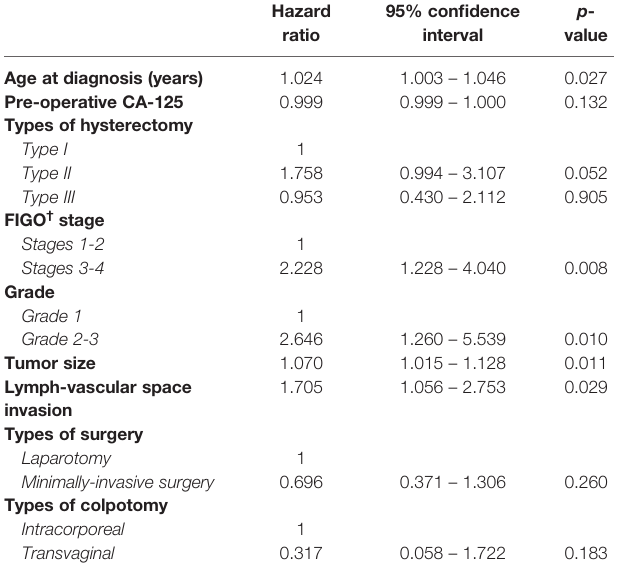
† FIGO, International Federation of Gynecology and Obstetrics.